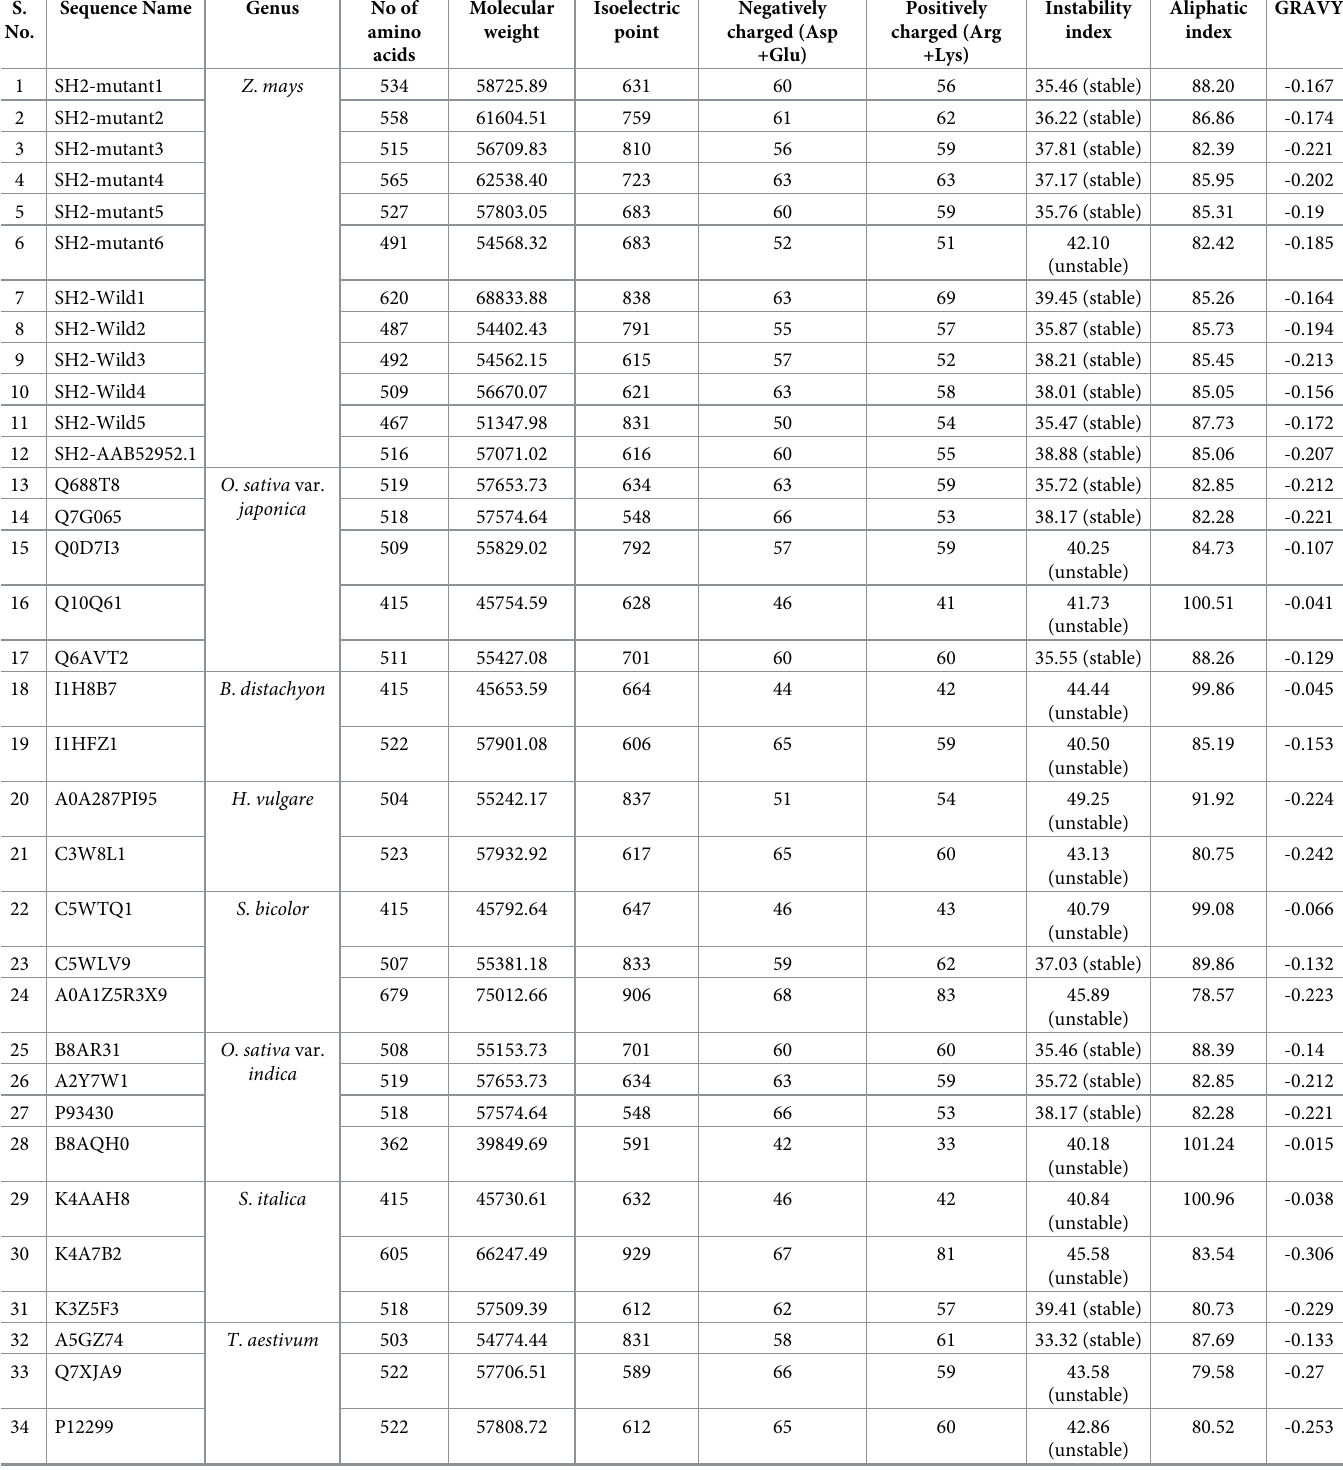
Table 5. Physiochemical properties of SH2 protein and orthologous protein. S.